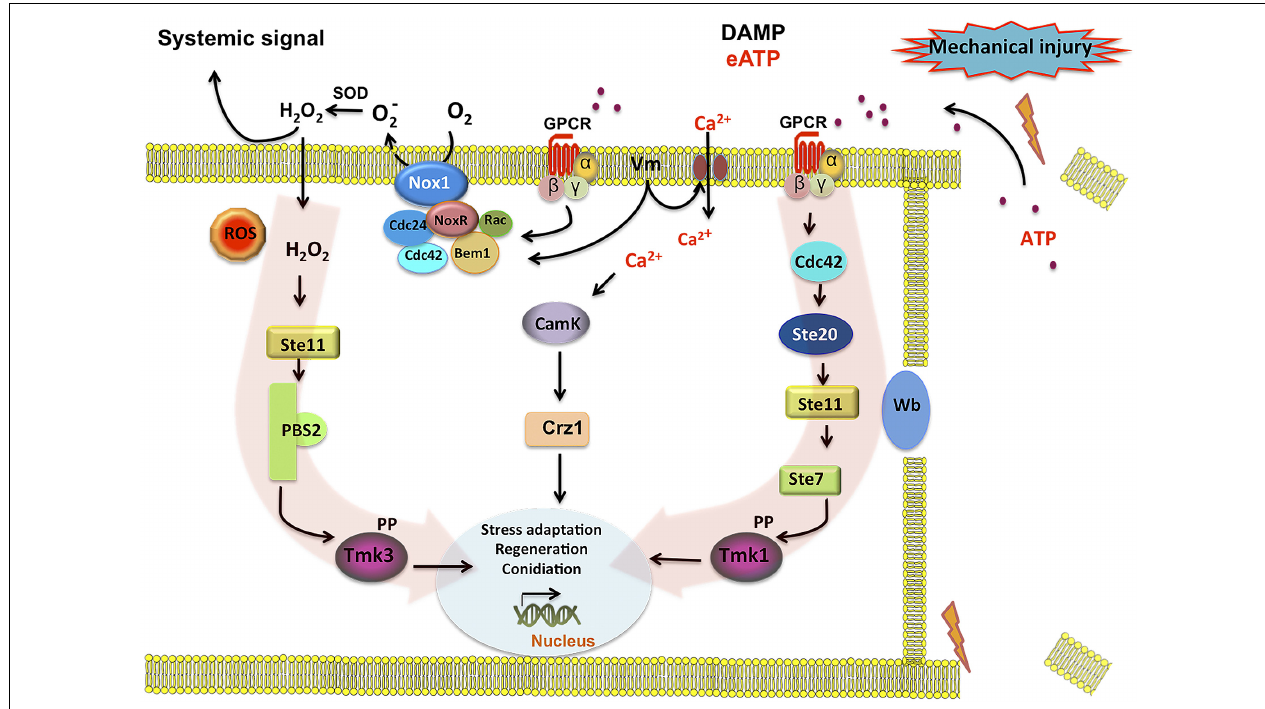
targets required for the damage response. Calcium influx may also lead to changes in membrane potential (Vm) and/or directly activate the Rac GTPase component of the NADPH oxidase (Nox1/NoxR) complex, generating O − 2 . A superoxide dismutase (Sod) converts O − 2 into H 2 O 2 that can diffuse into the cell, activating the Ste11 MAPK pathway, leading to Tmk3 phosphorylation. Phosphorylation of Tmk1 and/or Tmk3 results in the activation of the developmental program that results in the formation